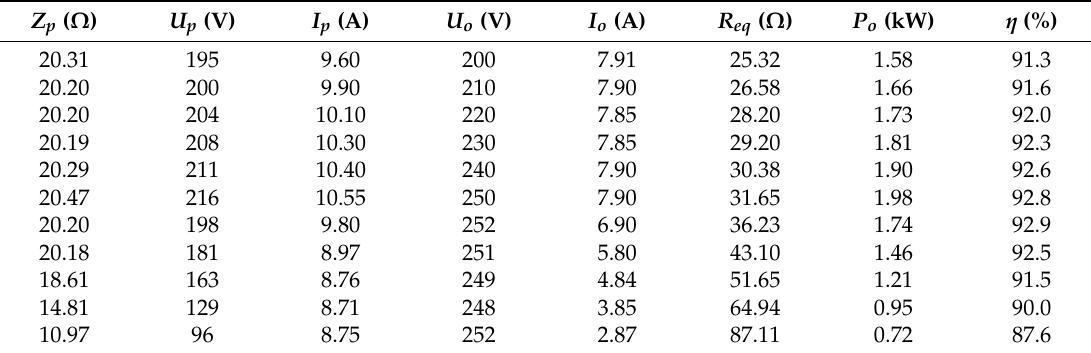
Table 2. Data of Table 2. Data of system.